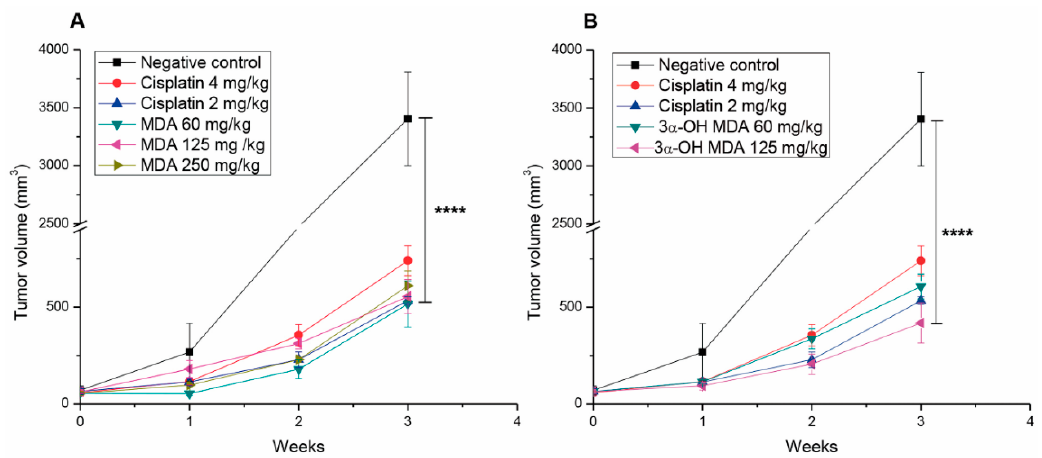
Figure 2. In vivo antitumor effect of masticadienonic and 3 α -hydroxymasticadienoic acids. The antitumor activities of MDA ( A ) and 3 α -OH MDA ( B ) were evaluated in nu/nu mice transplanted with human protate cancercells. The mice were subcutaneously inoculated with 3 × 10 6 cells on the right flank. Once the tumors reached 50 mm 3 , the mice received the indicated doses of MDA, 3 α -OH MDA, cisplatin or vehicle (sesame oil and 5% dimethyl sulfoxide ) at days 0, 7, 14 and 21. Each point represents the average ± SEM of six mice for each experimental group. **** p < 0.0001, significant differences compared with the negative control. Data were analyzed by two-way ANOVA following a multiple comparisons test (Tukey test). All the treated groups were statistically different from negative groups.